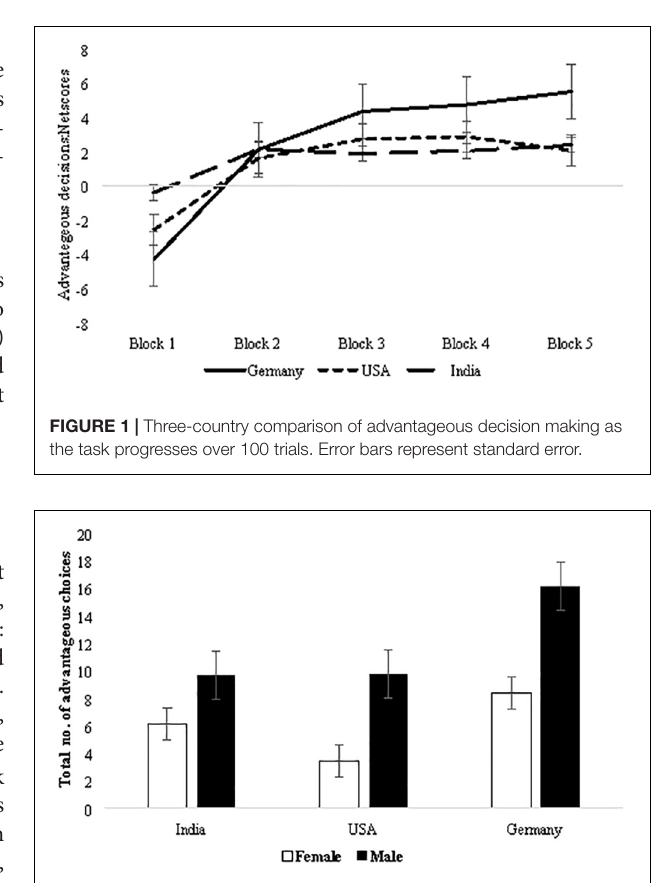
Results of decision making in the uncertainty trials (early phase) and risk trials (late phase) showed no main effect of block, = 0 . 004, and no main effect of F (1,524) = 1.93, p = 0.166, η 2 p = 0 . 004, but a significant country, F (2, 524) = 1.16, p = 0.313, η 2 p = 0 . 009 main effect of sex, F (1,524) = 4.97, p = 0.026, η 2 p ( Table 2 ). Looking at the interactions, there was no effect of sex = 0 . 005. The interaction and block, F (1,524) = 2.82, p = 0.094, η 2 p of age and block was also not significant, F (1,524) = 0.002, = 0 . 001. The interaction between country and p = 0.962, η 2 p = 0 . 057 block was significant, F (2,524) = 15.76, p < 0.001, η 2 p (mean net scores: Germany uncertainty blocks = − 2.20 vs. risk blocks = 10.24, United States uncertainty blocks = − 1.10 vs. risk blocks = 4.81, and India uncertainty blocks = 1.71 vs. risk = 0 . country was significant, F (2,524) = 4.18, p = 0.016, η 2 p